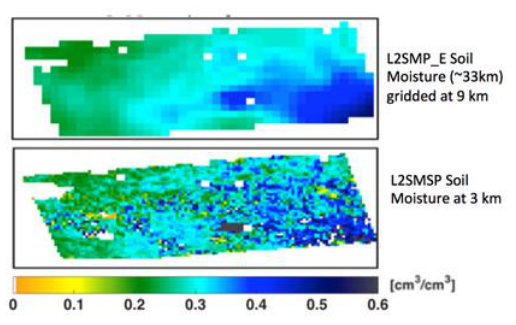
Figure 2: Example of an L2SMSP granule from Manitoba, Canada for date 15 th May, 2015, showing enhancement of spatial details of soil moisture retrievals through application of the L2SMSP algorithm. The L2SMSP shows more detailed